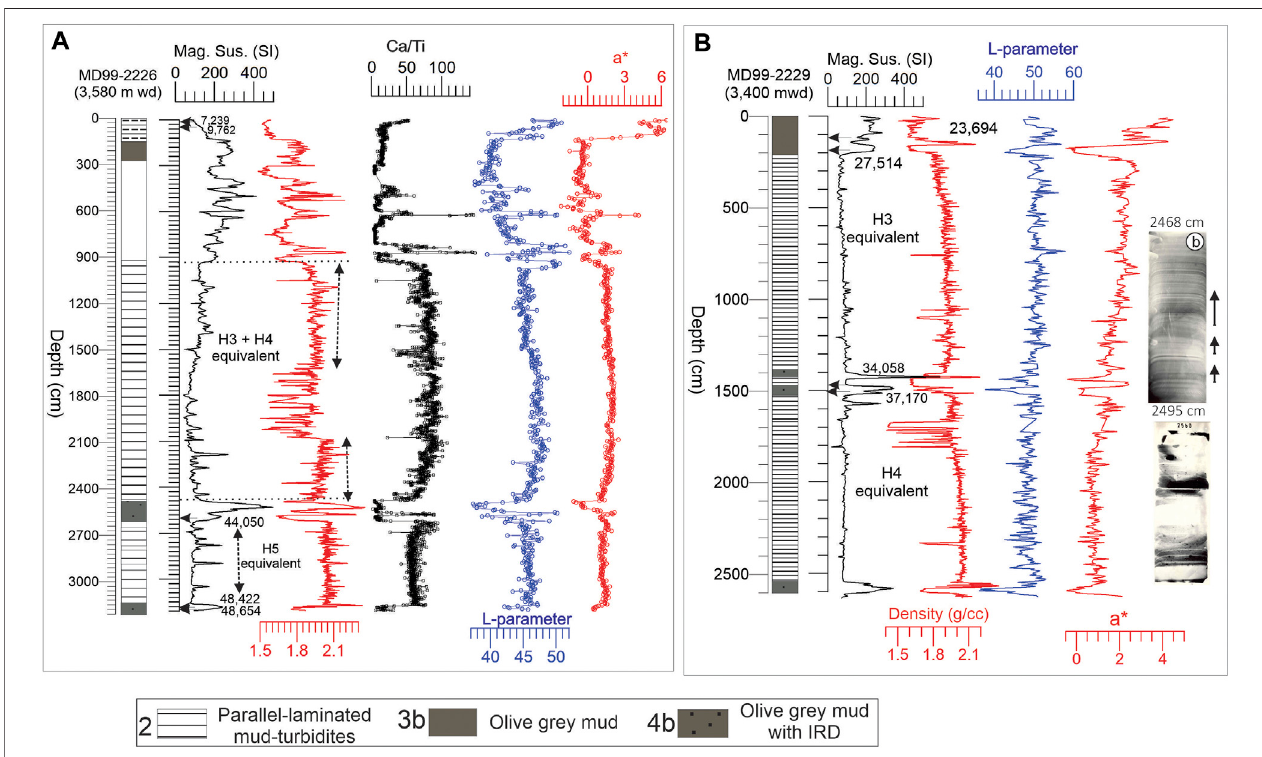
FIGURE 6 | (A) Physical properties (magnetic susceptibility and density) of bulk sediments, Ca/Ti ratios, and sediment color L* and a*-traces of core MD99-2226 are plotted. Five 14 C-AMS dates were used to identify H3 and H4 layers. (B) Thickness of H3 and H4 layers between 930 and 2595 cm of core MD99-2229 (Cf. Rashid et al., 2019a) is shown to compare with core MD99-2226. X-radiographic images of core MD99-2229 show fi ne-grained climbing ripple in which coarse silt (dark) and fi ne silt (white) clay layers irregularly alternate and a typical nepheloid fl ow layer deposit.